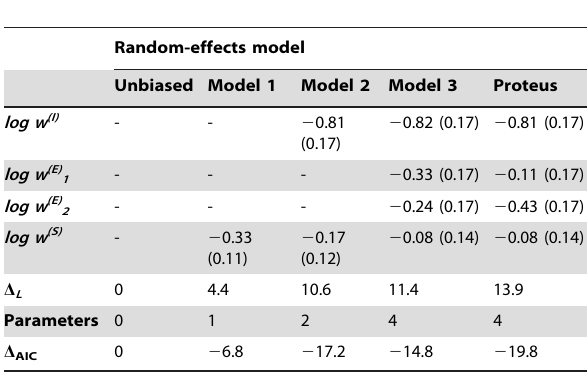
Table 1. Estimates of the weight function